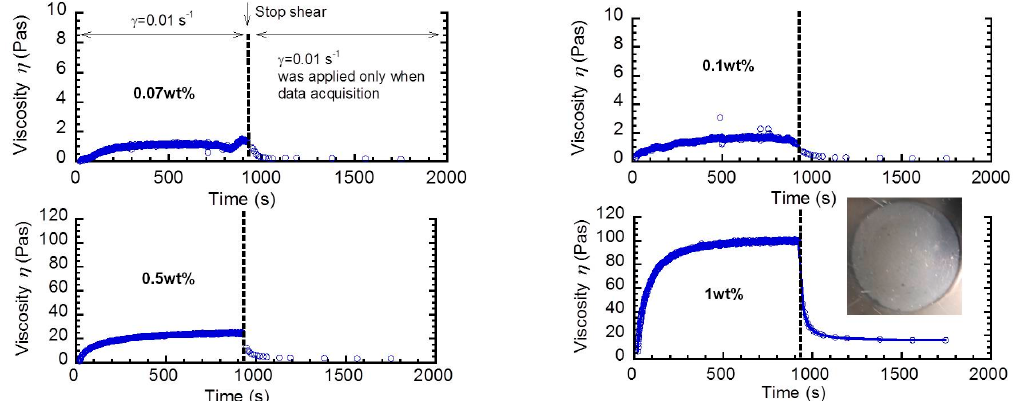
Figure 5. Recovery in the shear viscosity for sacran aqueous solutions with various sacran concentrations. Inset: Polarized photo for 1 wt.% sacran aqueous solution taken under the cross nicol.